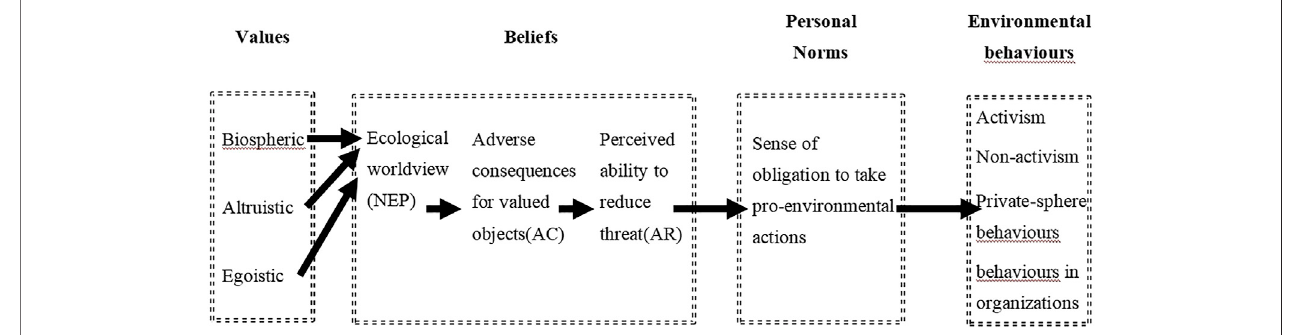
FIGURE 1 | A schematic representation of variables in the VBN theory of